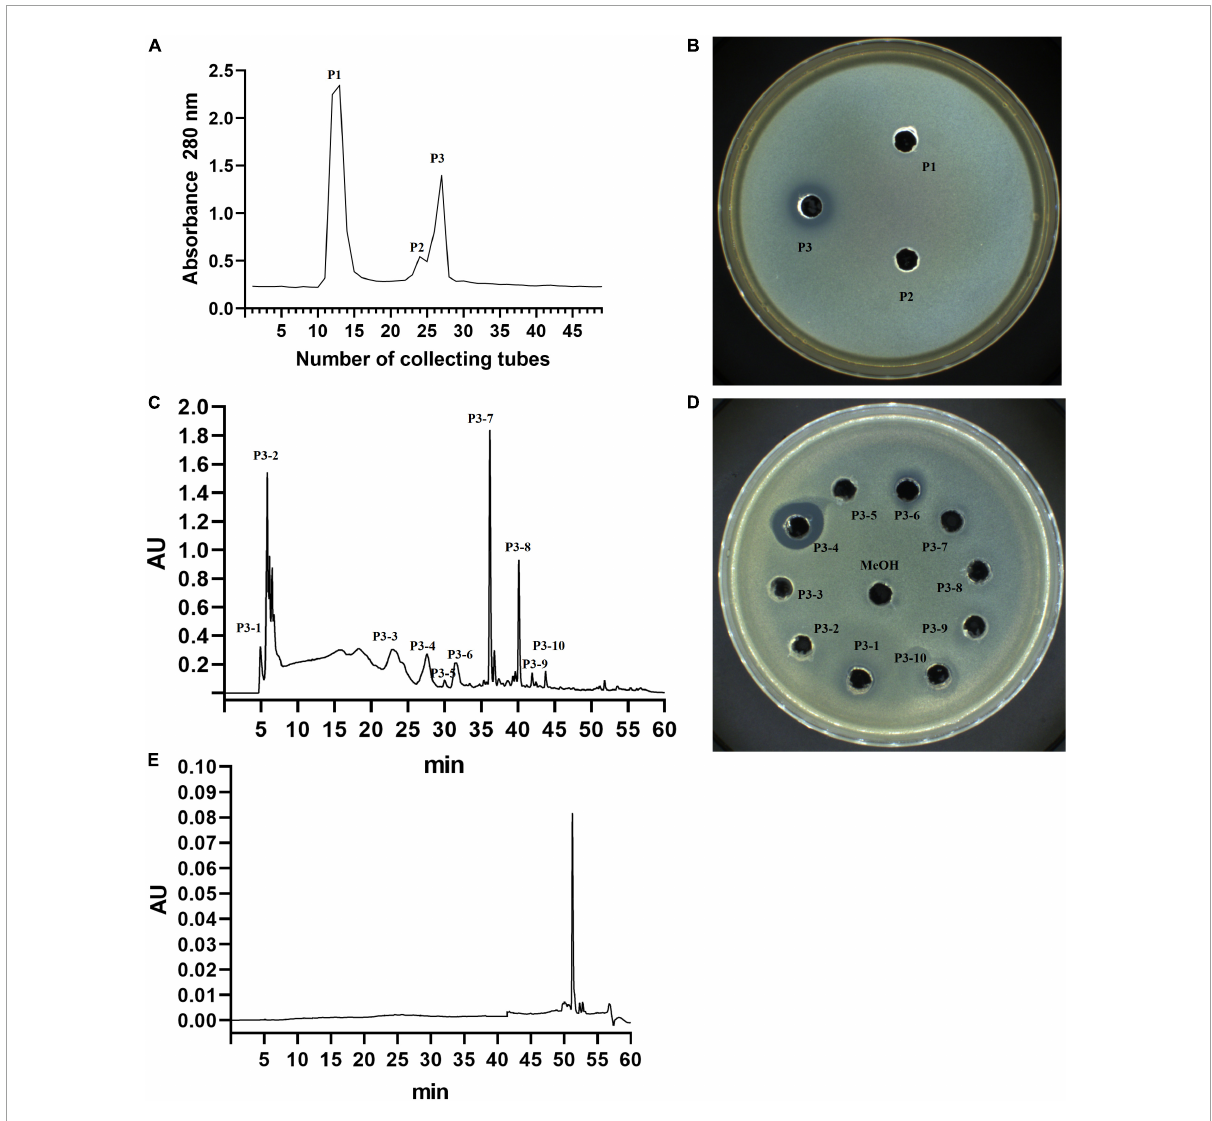
FIGURE4 Isolation and purification of YA215 lipopeptide extracts (YA215LE). (A) Purification of YA215LE by gel column chromatography. (B) The bacteriostatic activity of the P3 fraction by gel column chromatography on Escherichia coli . (C) Purification of the P3 fraction by semipreparative reverse-phase high-performance liquid chromatography (RP-HPLC) using a C18 column. (D) The bacteriostatic activity of the P3-4 fraction by semipreparative RP-HPLC on Escherichia coli . (E) Determination of the purity of the P3-4 fraction by